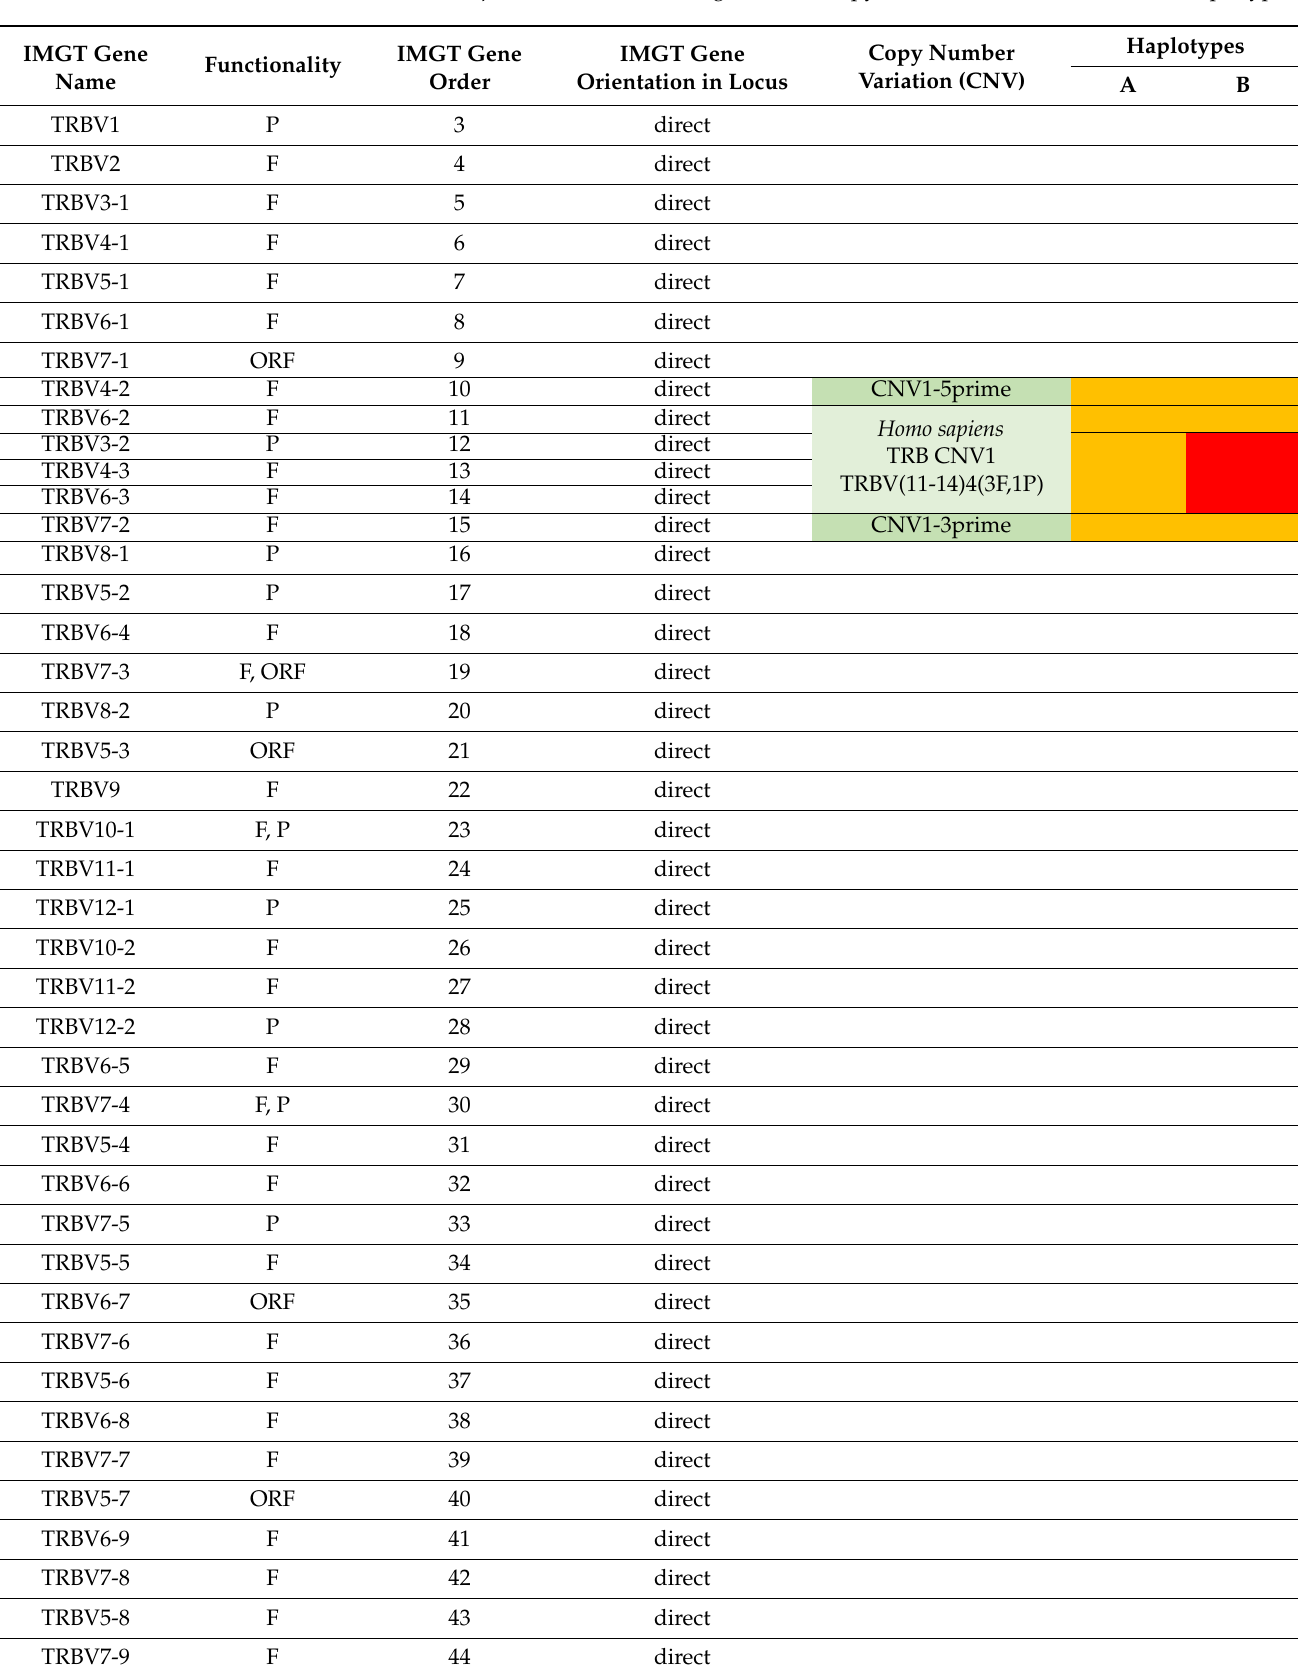
Table 7. Homo sapiens TRB locus: IMGT gene order, copy number variations (CNV) and